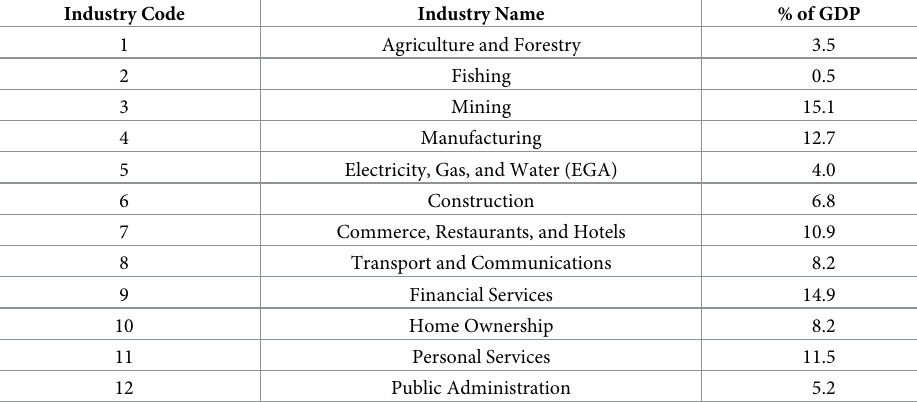
Table 1. Fraction (%) of the value of each industry in national GDP